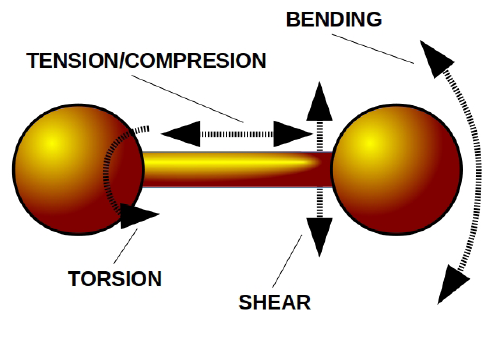
Figure 3: Forces and moments between the particles bonded through rotational elastic-brittle bonds (Abe et al.